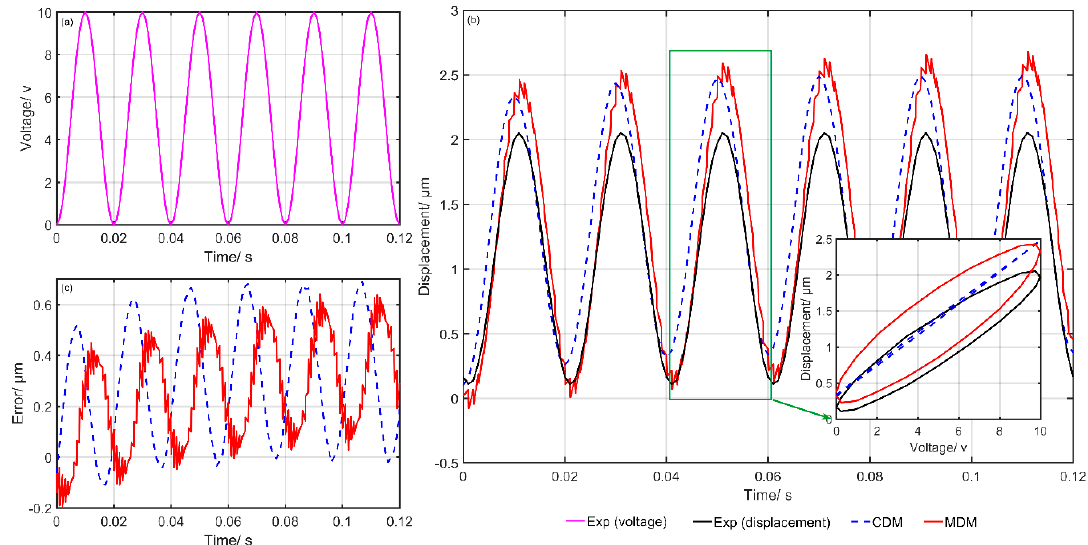
Figure 11. Exp6: Comparison of the experimental and simulation results of the CDM and MDM under u 5 ( t ) = 5sin ( 2 π · 50 t )+ 5: ( a ) Time histories of input voltage, ( b ) time histories of output displacements and ( c ) time histories of errors of the CDM and MDM.